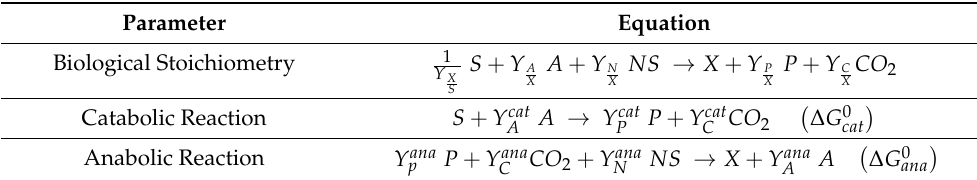
Table 1. Microbial growth parameters and the related models that describe the stoichiometric parameter analysis